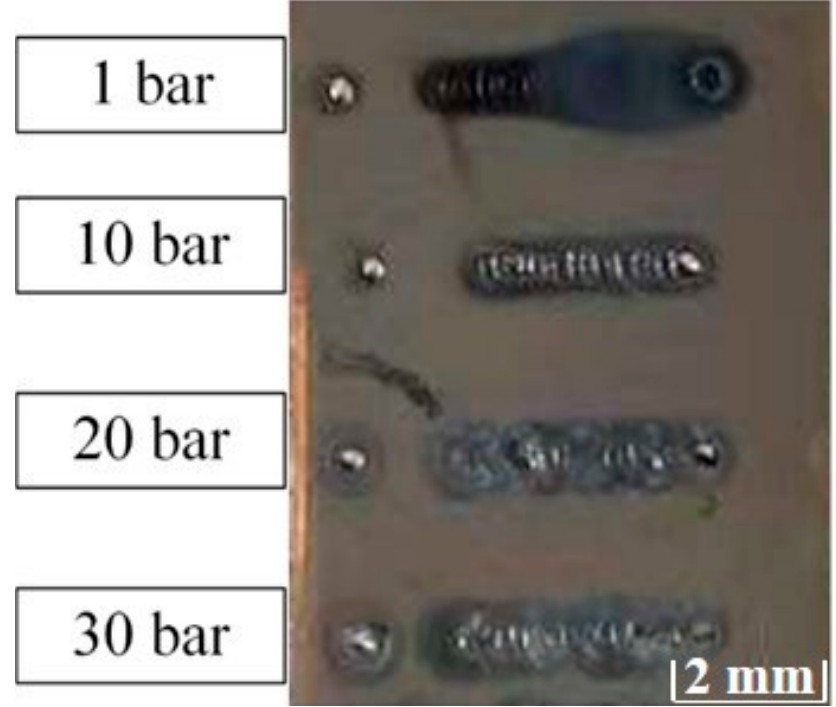
Figure 3. Macroscopic effect diagram of beryllium laser melting under different